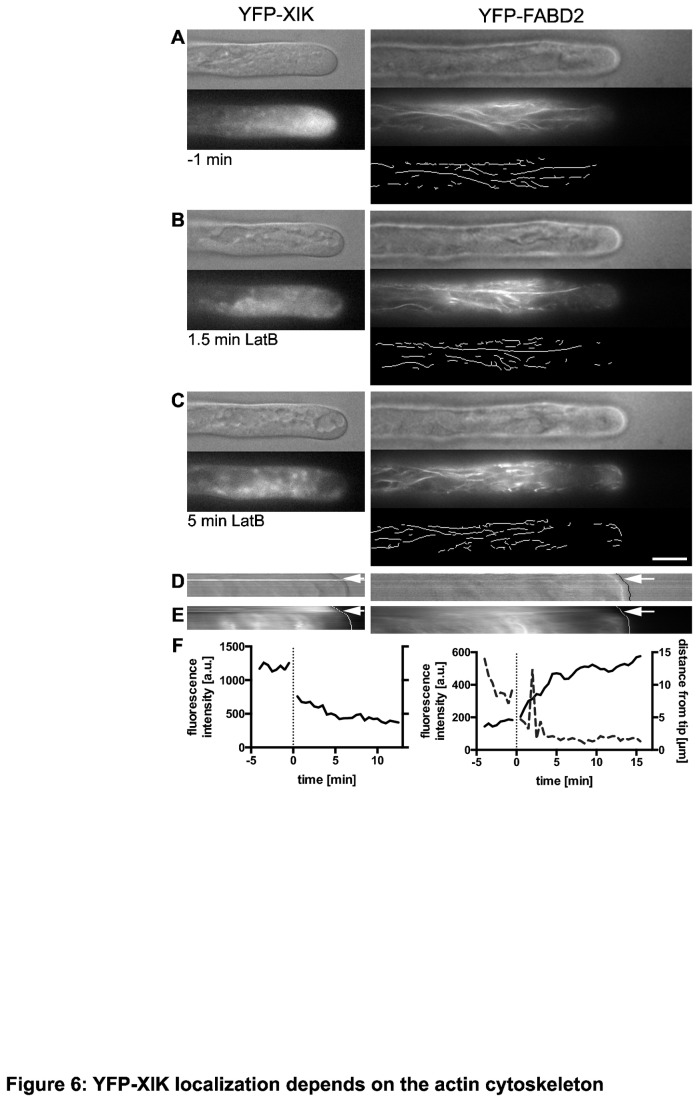
Treatment with the actin depolymerizing drug, LatB, disrupts YFP-XIK accumulation at the tip.Root hairs expressing YFP-XIK (left column) or YFP-FABD2 (right column) were treated with 100 nM latrunculin B (LatB) during observation on the microscope (n=8 for YFP-XIK; n=10 for YFP-FABD2). DIC and fluorescence images were captured in 30 s intervals. YFP-XIK images were captured near the center of the root hair, whereas YFP-FABD2 images show the cortical actin filaments. Representative images from Movies S4 and S5 at the indicated times are shown. Size bar for A-C: 10 µm.(A) Prior to treatment, YFP-XIK accumulated near the tip and actin filaments formed many, primarily longitudinal bundles in the shank. Computational detection of actin filaments is shown below the fluorescence image. Note that this actin marker does not label the fine actin mesh in the apical region of the root hair.(B) Within 1.5 min of LatB treatment, YFP-XIK intensity in the tip decreased while actin cables showed first signs of disorganization with the appearance of short filaments in the apical region. At this time, large vacuoles were seen to approach the tip (e.g. left DIC image).(C) After 5 min of LatB treatment, YFP-XIK was largely absent from the tip and formed larger clusters in the subapical and shank regions. YFP-FABD2 cables were still present in the shank and also were present in the tip region of the root hair. These areas were separated by a region with no or few actin filaments and low fluorescence intensity.(D) Kymograph of DIC images revealing growth of the root hair. Total height of the image represents 17 min (YFP-XIK) and 20 min (YFP-FABD2), respectively. Note that growth of the root hair stopped around 5 min after LatB application (arrow).(E) Kymograph of fluorescence images. YFP-XIK fluorescence was strongest near the tip before LatB application (arrow) but then dropped quickly in the tip region. By contrast, YFP-FABD2 signal in the tip was low prior to treatment but increased in the presence of LatB. Curved white lines indicate position of the root hair tip.(F) Quantitative analysis of YFP-XIK and YFP-FABD2 accumulation in the tip. Solid lines indicate fluorescence intensities of the two markers within the first 2 µm of the root hair over time. Dashed line in right graph indicates the distance of the front-most actin filament from the tip (see lower panels in A-C). Vertical dotted line indicates start of LatB treatment during which root hair shifted and focus had to be reestablished.